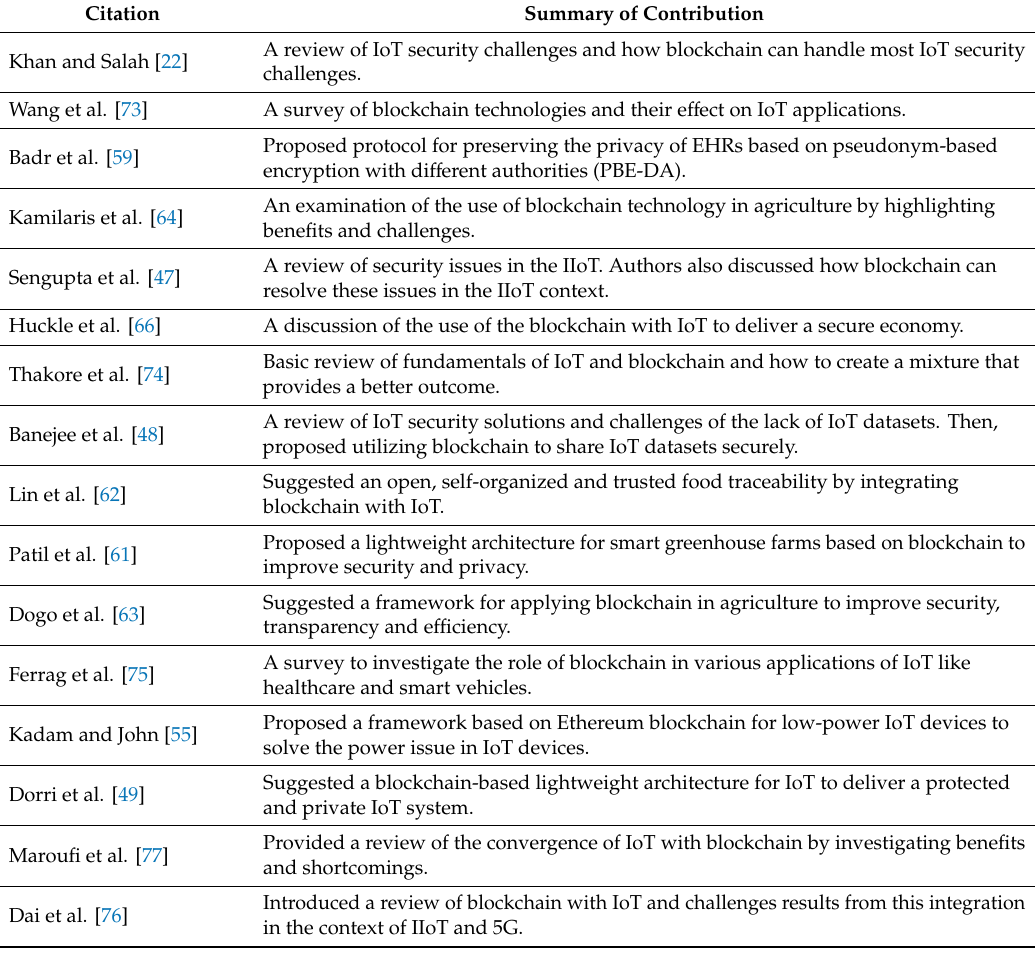
Table 5. Summarized contributions of recent studies that examined the integration of blockchain with